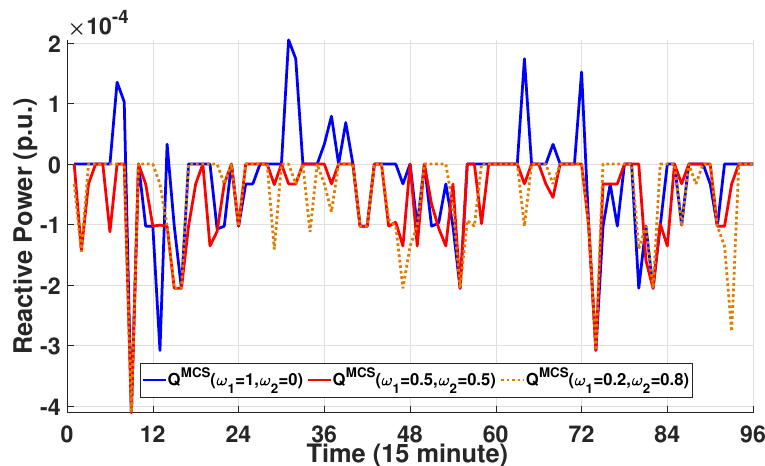
Figure 15. Total reactive power consumption scheduled for three MCSs with different weights.